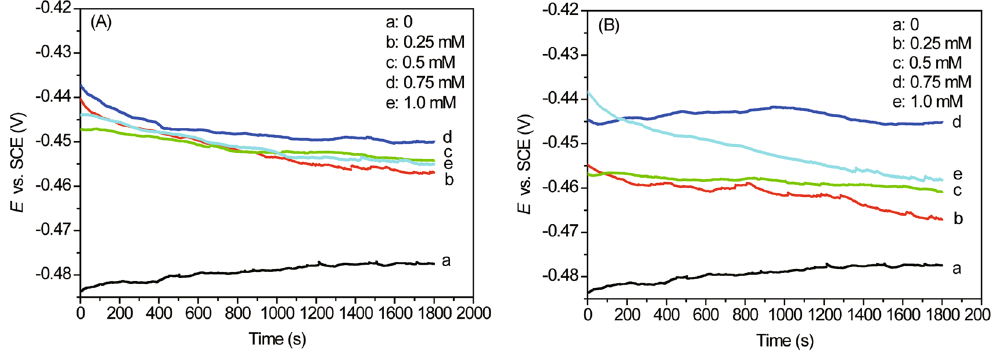
Figure 2. Time variation of the open circuit potential (OCP) for carbon steel in 0.5 M HCl solution without/ with different concentrations of BAIL1 ( A ) and BAIL2 ( B ).